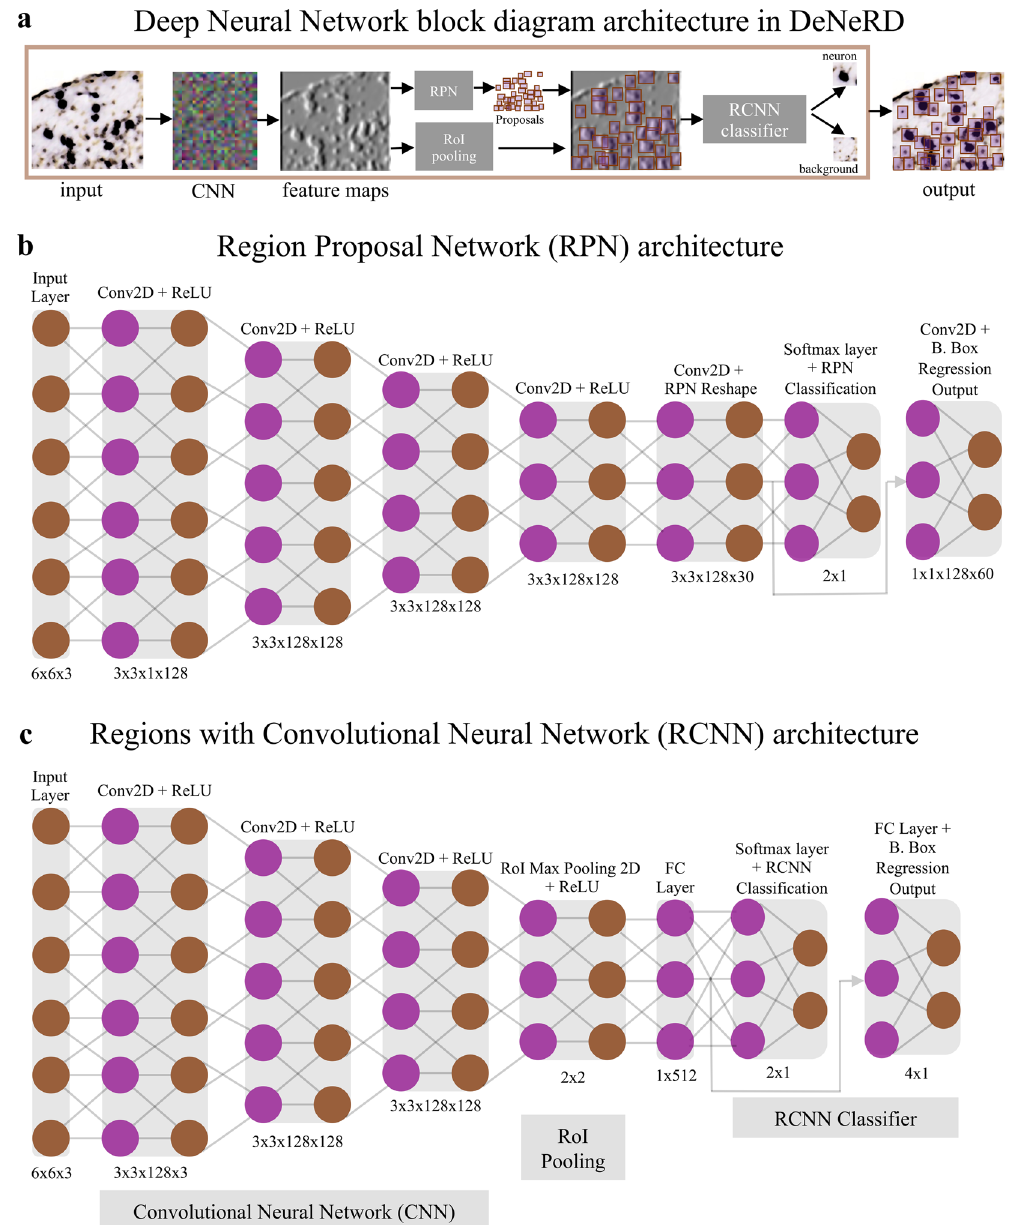
Figure 2. The Deep Neural Network architecture in the DeNeRD ( Neuron Detector ) pipeline for neuron detection. ( a ) The block diagram of Faster R-CNN in DeNeRD . A small brain section image is used as input that goes through a series of convolutional stages, RPN (Region Proposal Network), ROI (Region of Interest) Pooling and RCNN classifier. The outputs of RPN and ROI Pooling are combined and then fed as input to the RCNN classifier, which distinguishes the neurons from the background class. ( b ) RPN Architecture with convolutional, ReLU (Rectified Linear Unit) and pooling layers. ( c ) RCNN architecture with convolutional, ReLU, pooling and fully connected layers. The purple and brown colored nodes represent the different layers in the deep neural network which have functionally distinct roles in the feature processing of the input brain section